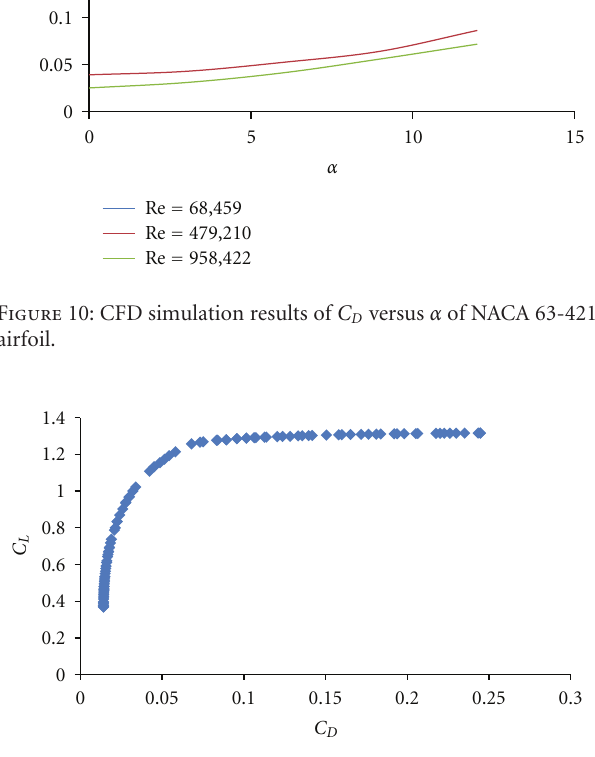
Figure 11: 2D presentation of non-dominated solutions of C L versus C D